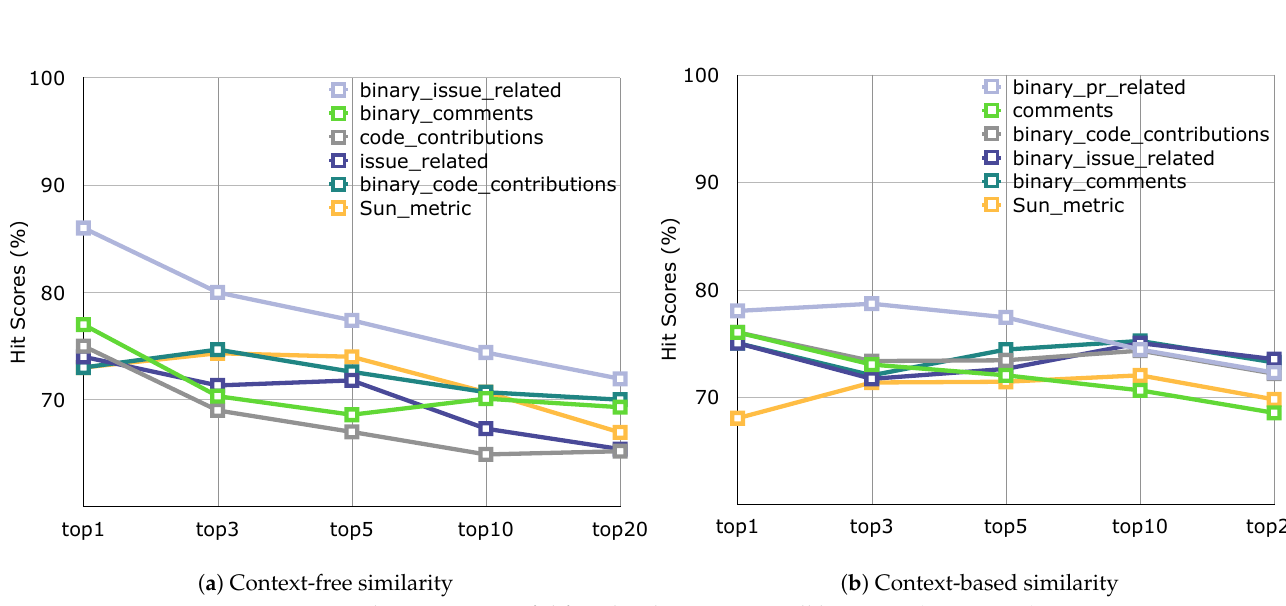
Figure 9. The most successful five developer metrics all hit scores